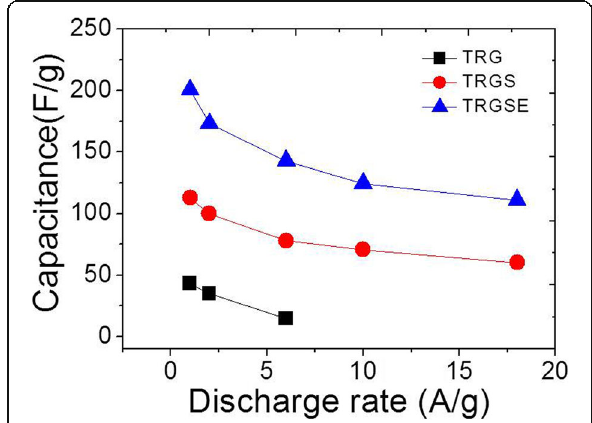
Fig. 9 The specific capacitance response of TRG, TRGS, and TRGSE cells at various discharging rates